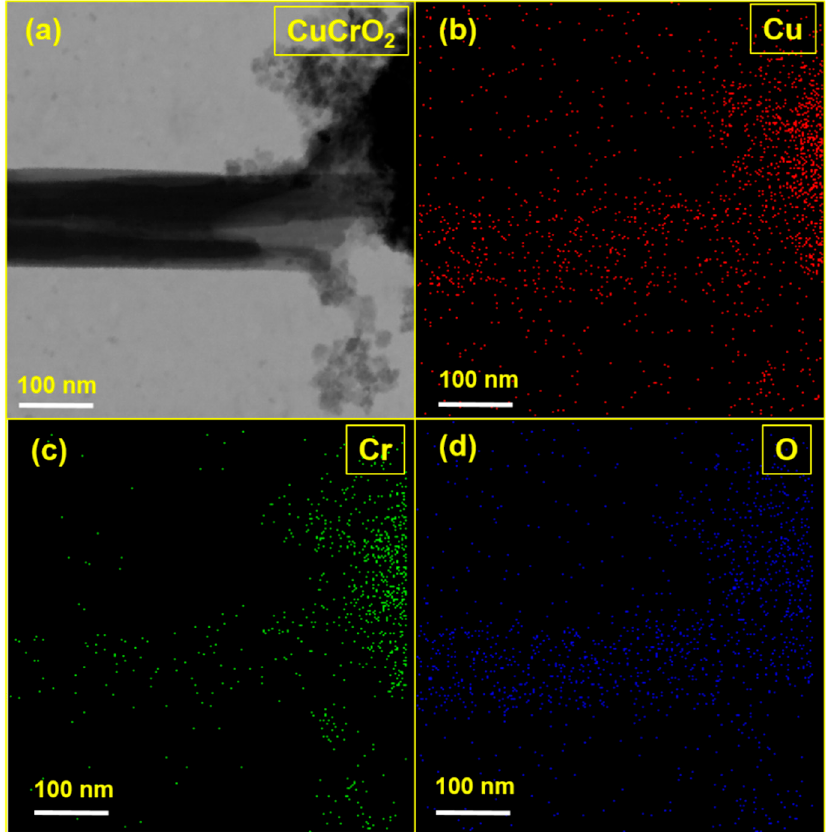
Figure 11. ( a ) STEM image of the CuCrO 2 hollow nanotube, ( b ) Cu, ( c ) Cr, ( d ) O.